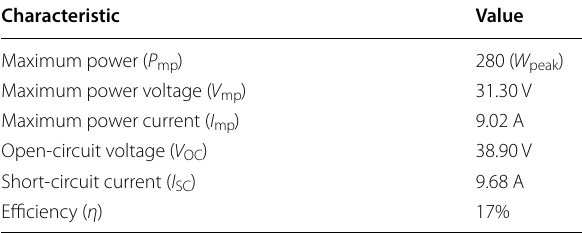
characteristics of Vision polycrystalline panels 280Wp (2019)